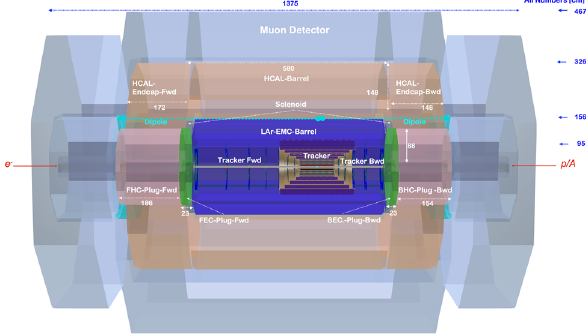
Fig. 4 Side view of the updated baseline LHeC detector concept, pro- viding an overview of the main detector components and their loca- tions. The detector dimensions are about 13m length and 9m diame- ter. The tracker is setup using pixel, macropixel and strip detectors. The barrel elctromagnetic LAr-calorimeter EMC (in blue) surround- ing the tracking region. The solenoid magnet is placed at radii imme- diately outside the EMC-Barrel, and is housed in a cryostat, which it shareswiththeweakdipolemagnetthatensureshead-oncollisions.The hadronic calorimeter HCAL in the barrel part (colored orange; it uses steel and scintillating tiles) is located outside of the solenoid. The for- ward/backward electromagnetic calorimeters FEC/BEC (in green) and hadronic calorimeters FHC/BHC (in bright orange) are using Si-based sensitive and readout technology and as absorbers W/Pb and W/Cu, respectively [1,2]. The muon detector (in grey) forms the outer shell of the detector. The detector description has been setup using DD4hep